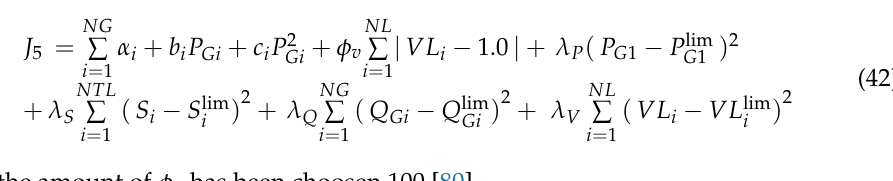
Table 4. The optimization results for Type 3.